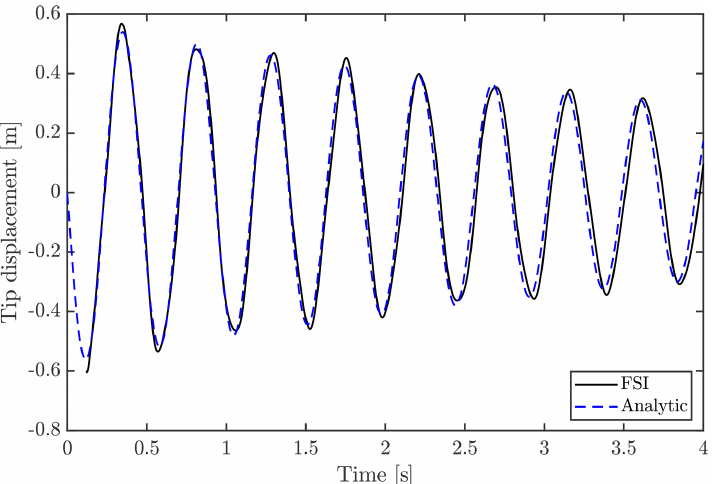
Figure A1. Tip displacement using analytical expression, compared to result from FSI-CFD with 600mm initial tip displacement. Note that the FSI-CFD result is shifted with the equilibrium position, due to gravity, and a quarter period to the right.